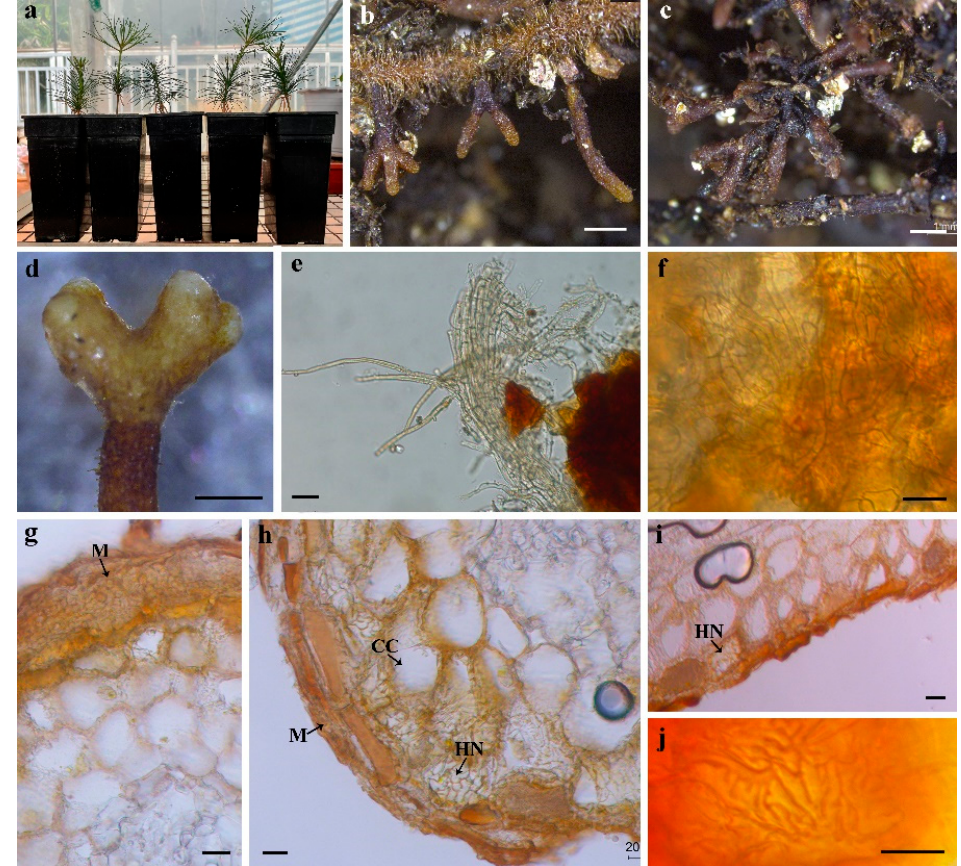
Figure 2. ( a ) Six-month-old Pinus armandii seedlings inoculated with Choiromyces sichuanensis in pots. ( b,c ) Ectomycorrhizal tips after six-month inoculation ( bars = 1 mm). ( d ) Detail of the surface showing sparse emanating hyphae ( bars = 1 mm). ( e ) Septate and see-through hyphae emanating and rhizomorphs from the outer mantle layer ( bar = 20 µ m). ( f ) Plan view of the inner mantle ( bar = 20 µ m). ( g , h ) Cross-section showing the mantle (M), cortical cells (CC), and Hartig net (HN) ( bar = 20 µ m). ( i ) Tangential section showing Hartig net (HN) ( bar = 20 µ m). ( j ) Plan view of the outer mantle showing irregular tree branch–like pattern ( bar = 10 µ m).